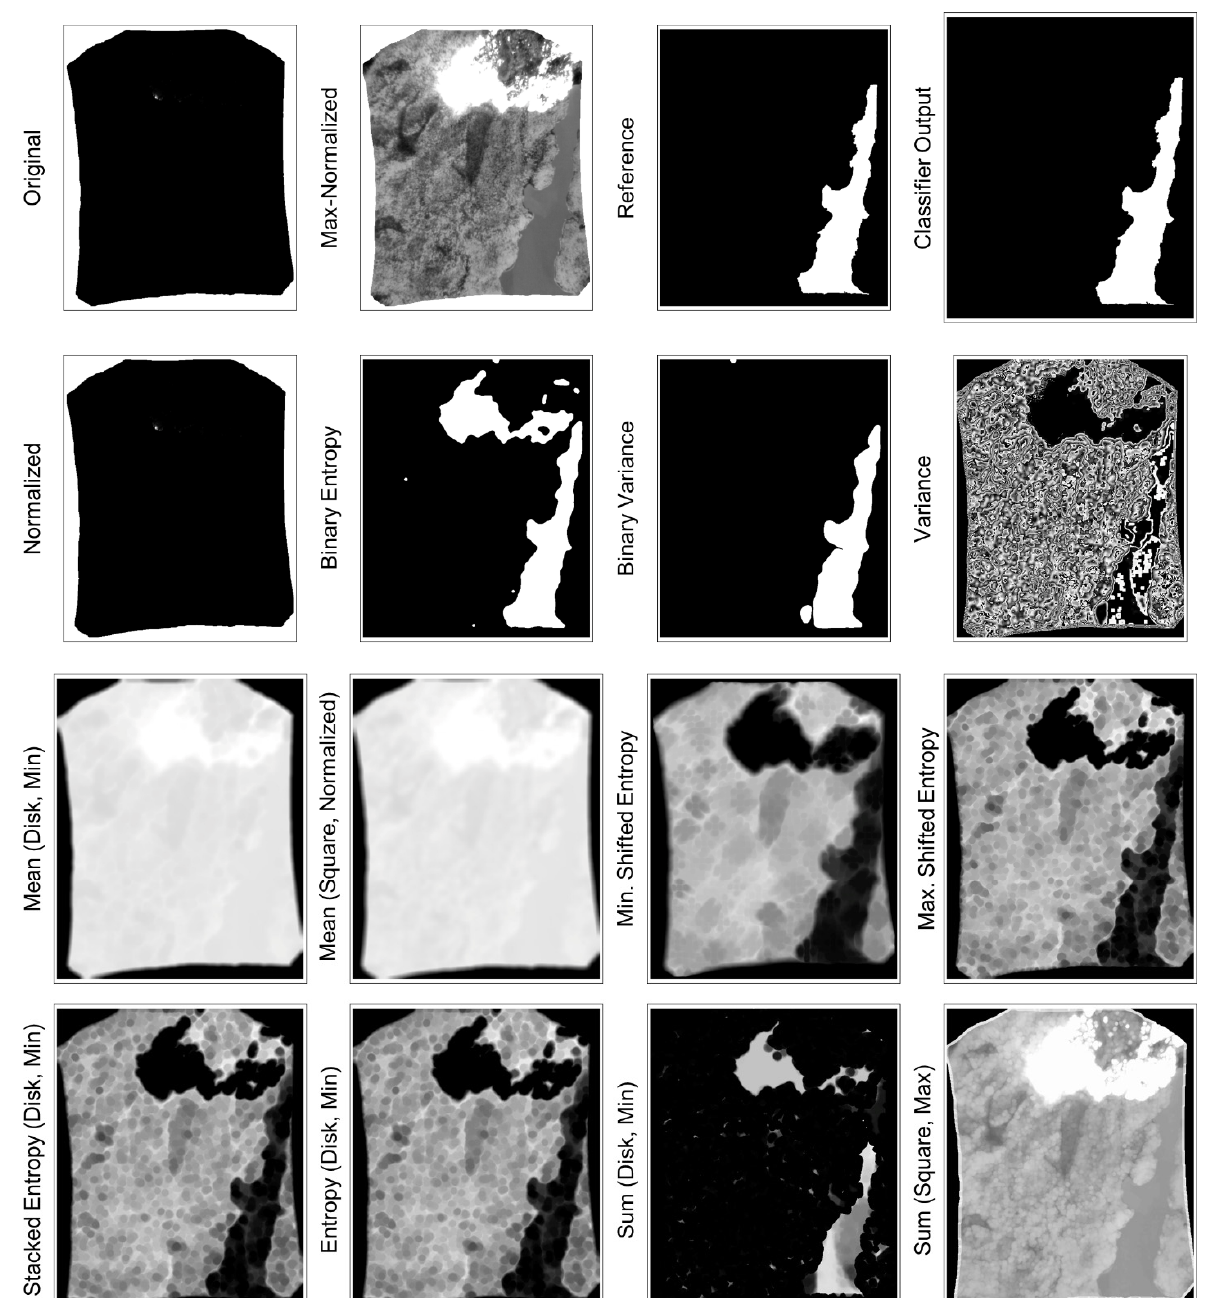
Figure 8. Sample of significant features for a fire pixel-containing IR image. Original and normalized images reflect the suppressed detail that can occur when IR images containing active wildfire are processed by standard image processing libraries. As described in Appendix A, the max-normalization technique can help preserve this detail.